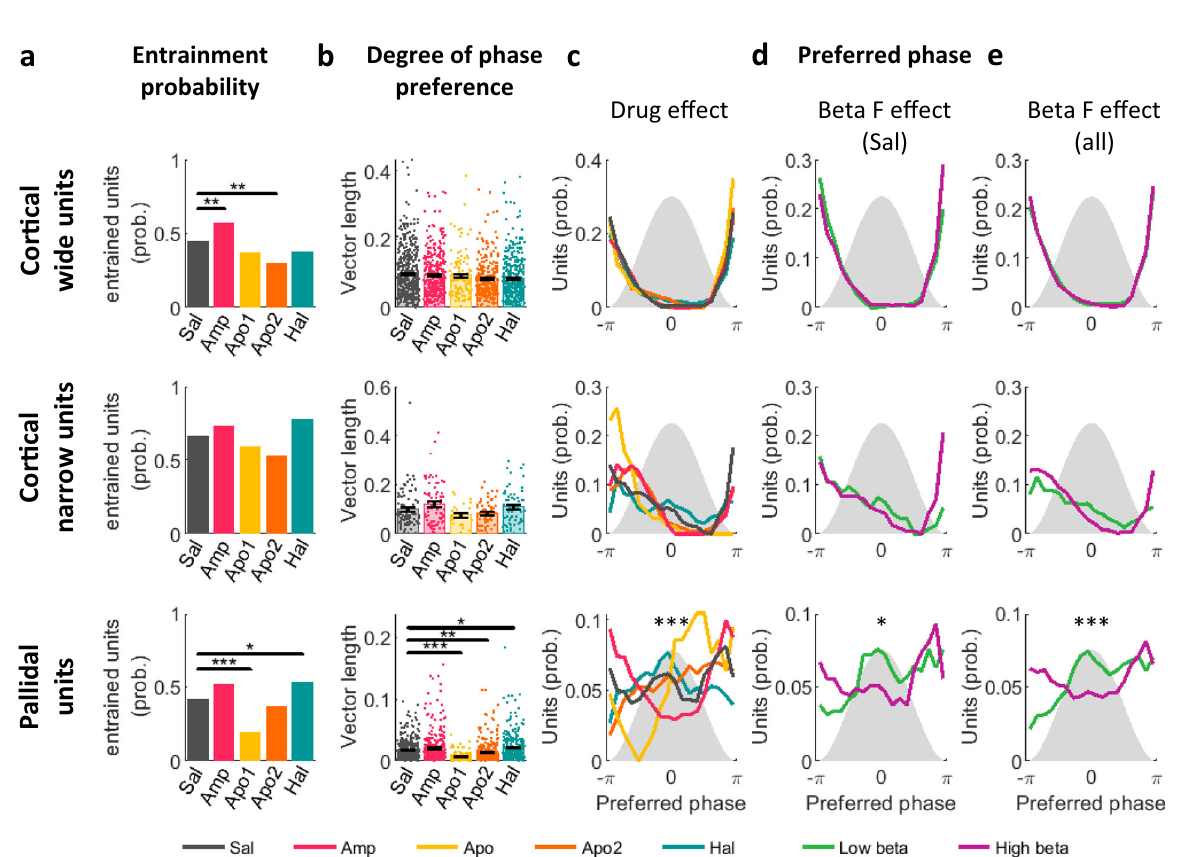
Fig. 5 LFP beta-oscillation frequency affects preferred phase of entrained units. Properties of unit-LFP entrainment in the beta-range frequency band of cortical wide, narrow, and pallidal units. a Fraction of entrained units out of all units recorded in parallel to oscillatory LFP ( N wide = 1559, N narrow = 303, N = 1374). Dopaminergic drugs modulated entrainment probability of cortical wide (Chi-square test, Amp: p = 0.005, Apo2: 0.0017) and pallidal pallidal (Apo1: p = 1.9e-4, Hal: p = 0.045) units. b Degree of phase preference, assessed per unit by the vector-length of the spike phase circular average (mean ± STE). Single points indicate individual unit values. Dopaminergic drugs modulated pallidal unit vector-length ( N = 1374, Kruskal – Wallis test followed by post-hoc Tukey test, Apo1: p = 9.9e-9 a , Apo2: 0.0047, Hal: 0.03). c – e Preferred phase of entrained units. Gray shadow: LFP beta-cycle, x -axis: LFP beta phase. y -axis: unit probability to lock to a given phase. c Entrained units grouped by drug condition. d Oscillatory entrained saline units, grouped by the unit beta frequency. e Oscillatory entrained units from all drug conditions, grouped by the unit beta frequency. d – e Units were segregated into low-beta (green) and high-beta (purple) groups according to the unit beta-frequency using a 15 Hz cutoff. Pallidal unit preferred phase was modulated by drug condition ( c ; circular-median test, N = 605, p = 9.7e-7), and unit beta-frequency in saline units ( d ; N = 143, p = 0.049) and for all drug conditions ( e ; N = 553, p = 0.0006). Test results can be found in Table-S11. Source data are provided as a Source Data fi le. * p < 0.05, ** p < 0.01, *** p < 0.001, a post-hoc p -value resolution was limited to 9.9e-9. LFP: local fi eld potential, Sal: saline, Amp: amphetamine, Apo1/2: Apomorphine phase 1/2, Hal: haloperidol, prob: